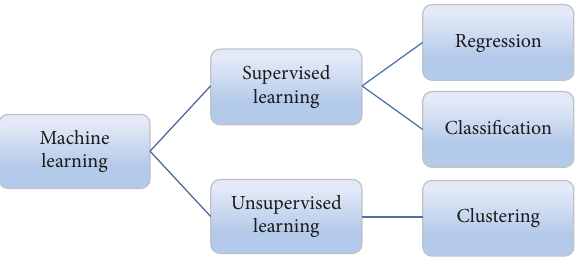
Figure 2: Machine learning